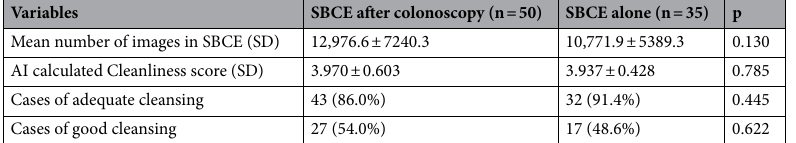
Table 2. Analysis of artificial intelligence algorithm calculated full length small bowel capsule endoscopy (N = 85). SBCE small bowel capsule endoscopy, AI artificial intelligence, SD standard deviation.